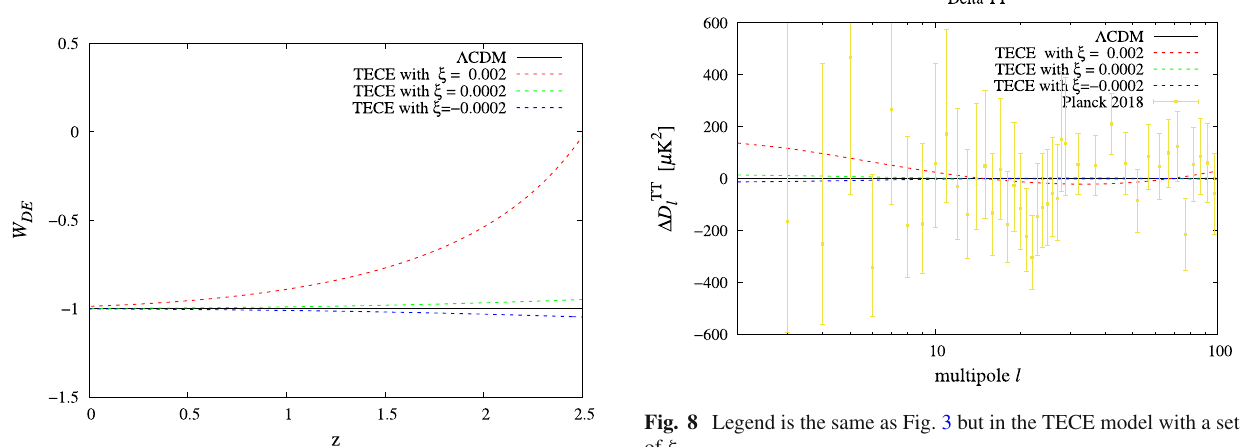
Fig. 6 Evolutions of the equation-of-state parameter w DE in (cid:2) CDM and TECE models